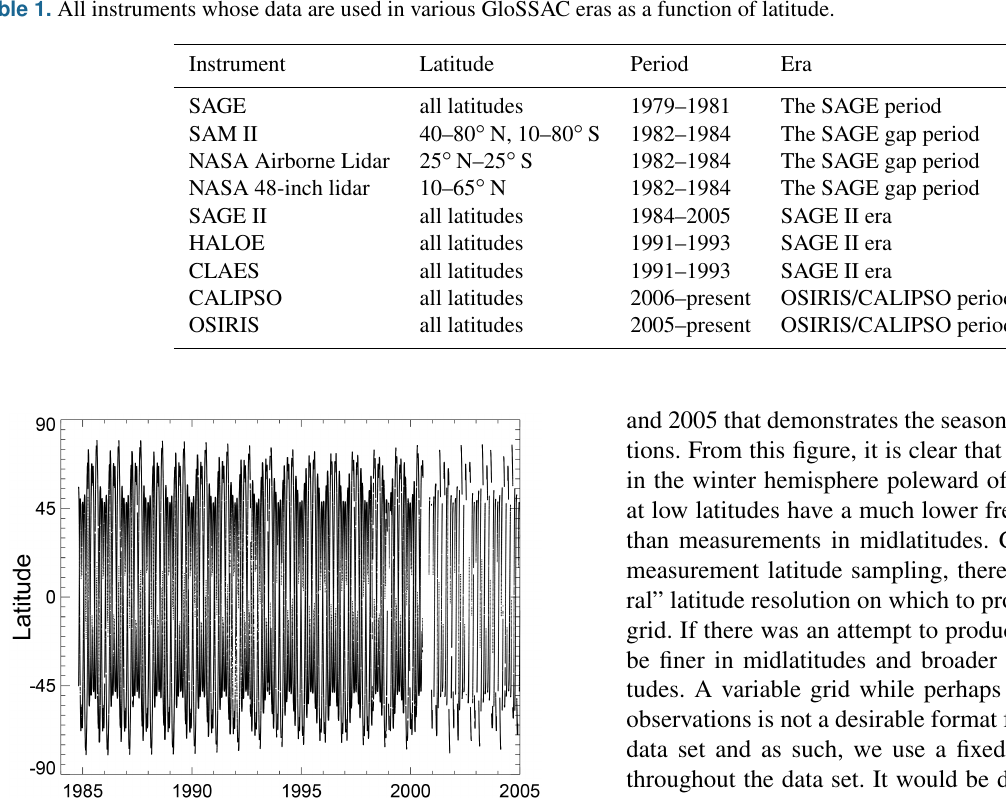
Table 1. All instruments whose data are used in various GloSSAC eras as a function of latitude.